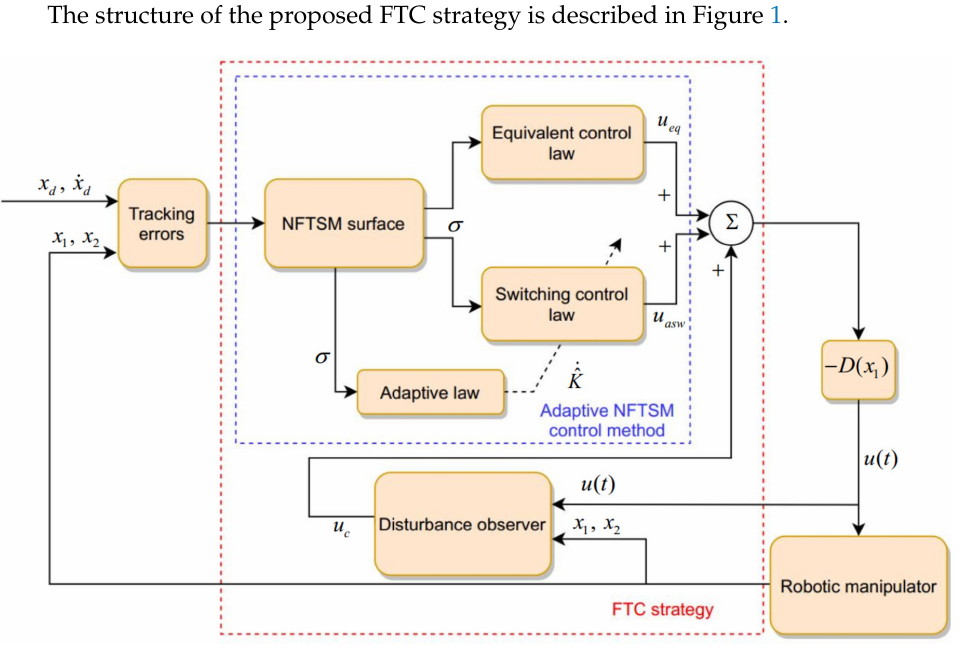
Figure 1. Structure of the proposed FTC